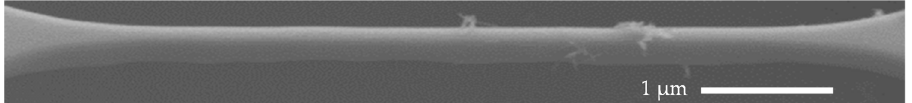
Figure 11. Enlarged view of specimen A before tensile testing.